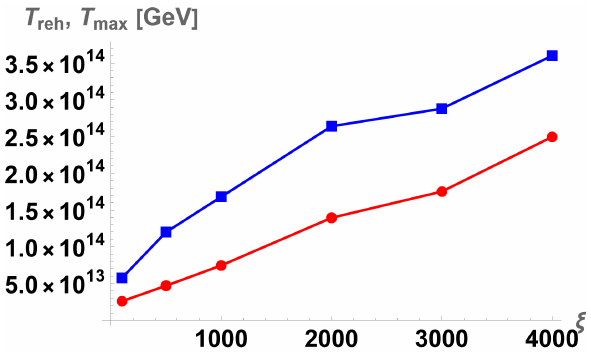
Figure 4 . Reheating temperature T reh and maximum temperature T max as a function of the Higgs non-minimal coupling ξ , in red and blue lines, respectively.